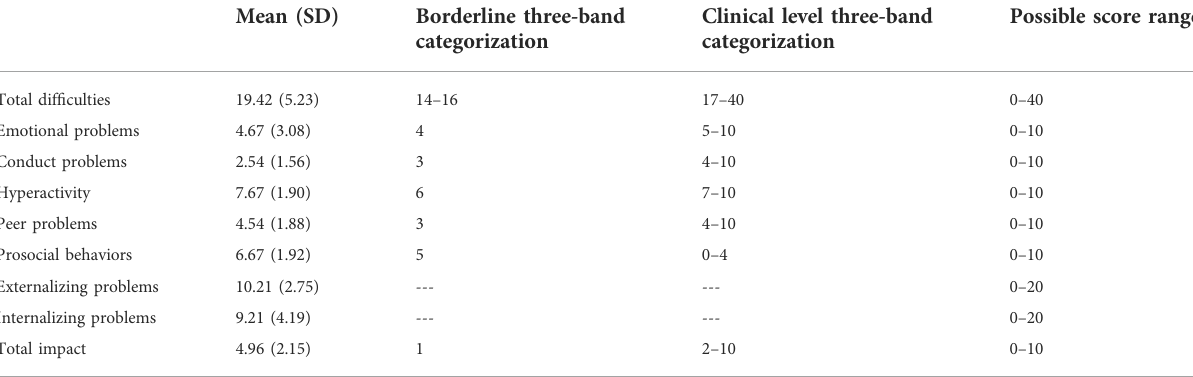
TABLE 3 Average ratings on the SDQ and proportion of individuals with WSS with elevated problem behaviors using the three band categorization ( N = 24). Mean